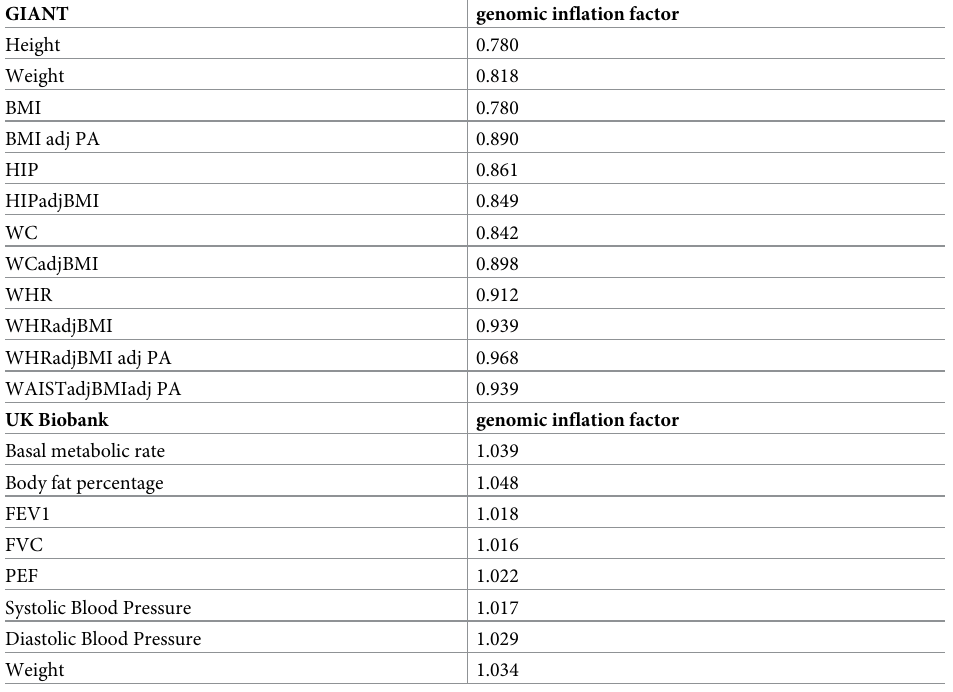
Table 1. Sex-specific GWAS and genomic inflation factor (lambda) for Cochran’s Q.